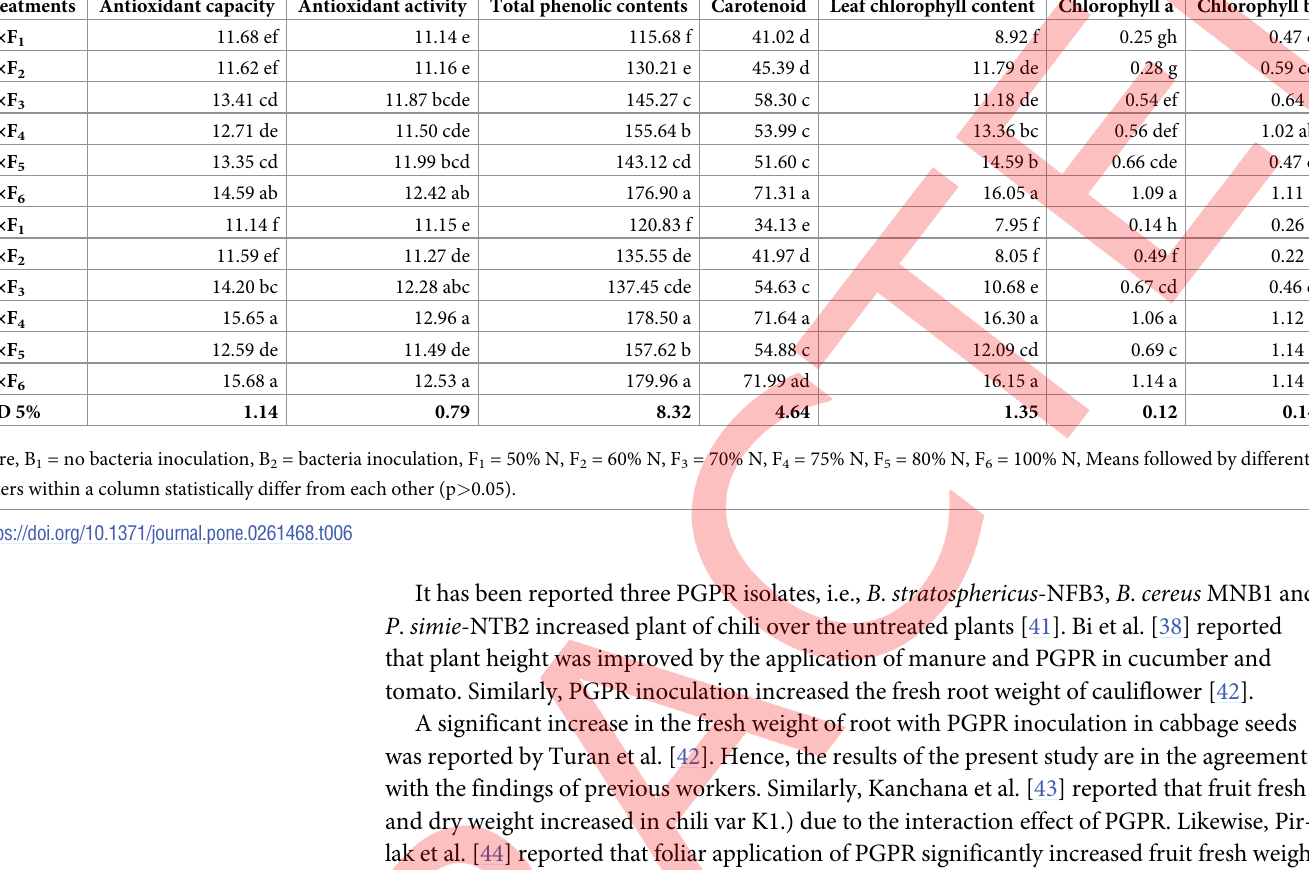
Table 6. The impact of different rhizobacteria inoculation on biochemical traits of chilli grown under different nitrogen doses. Treatments Antioxidant capacity Antioxidant activity Total phenolic contents Carotenoid Leaf chlorophyll content Chlorophyll a Chlorophyll b